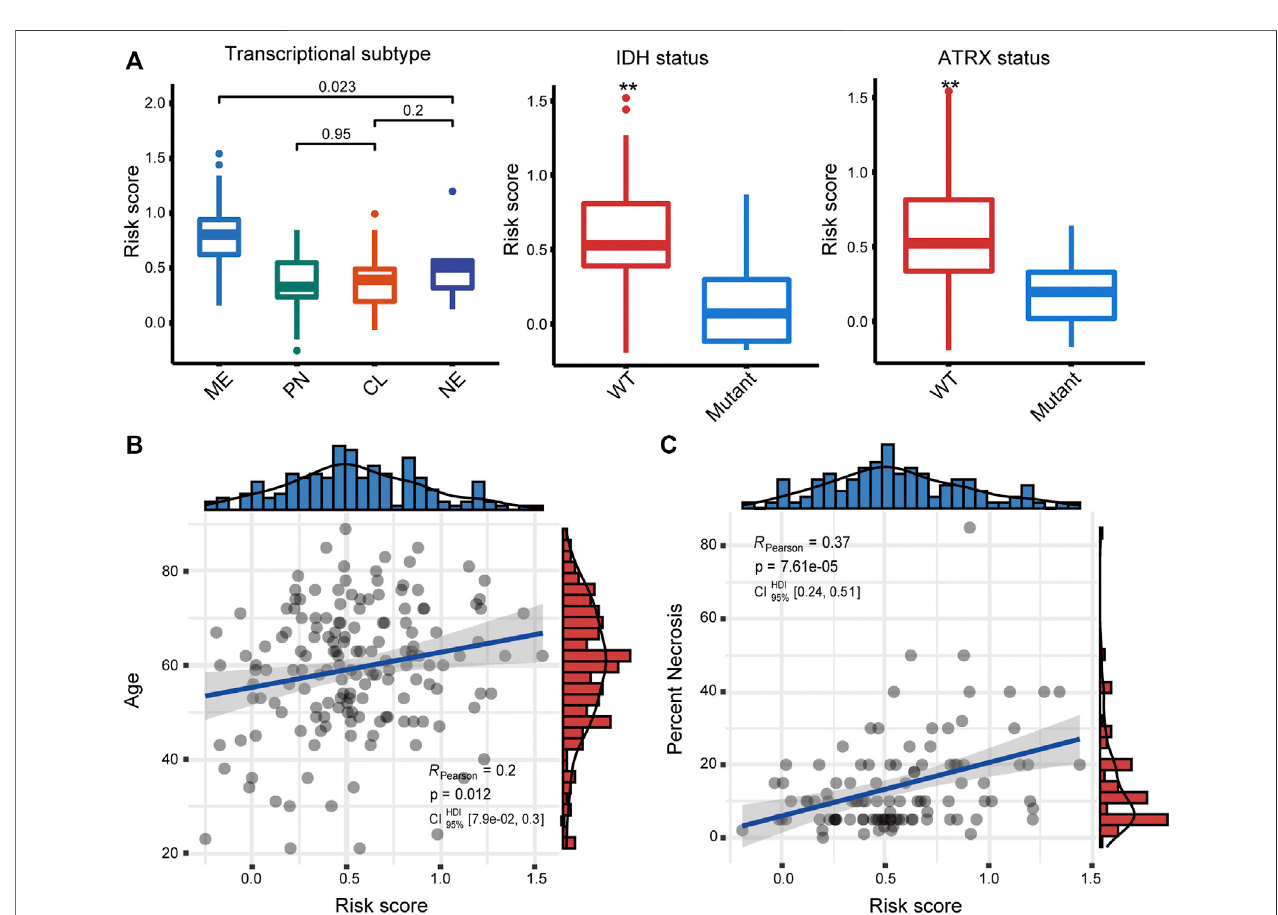
FIGURE2 |(A) Association ofthe riskscore with transcriptomesubtype, IDH mutation, and ATRX mutation status. Correlation betweenthe risk scoreand (B) age and (C) necrosis. ME, mesenchymal; PN, proneural; CL, classical; NE, neural.